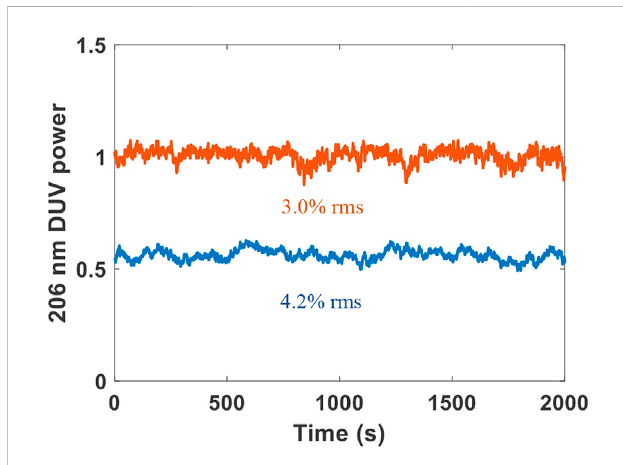
FIGURE 6 DUV power stability of 206 nm at .5 W and 1 W average power for a 2,000-s time